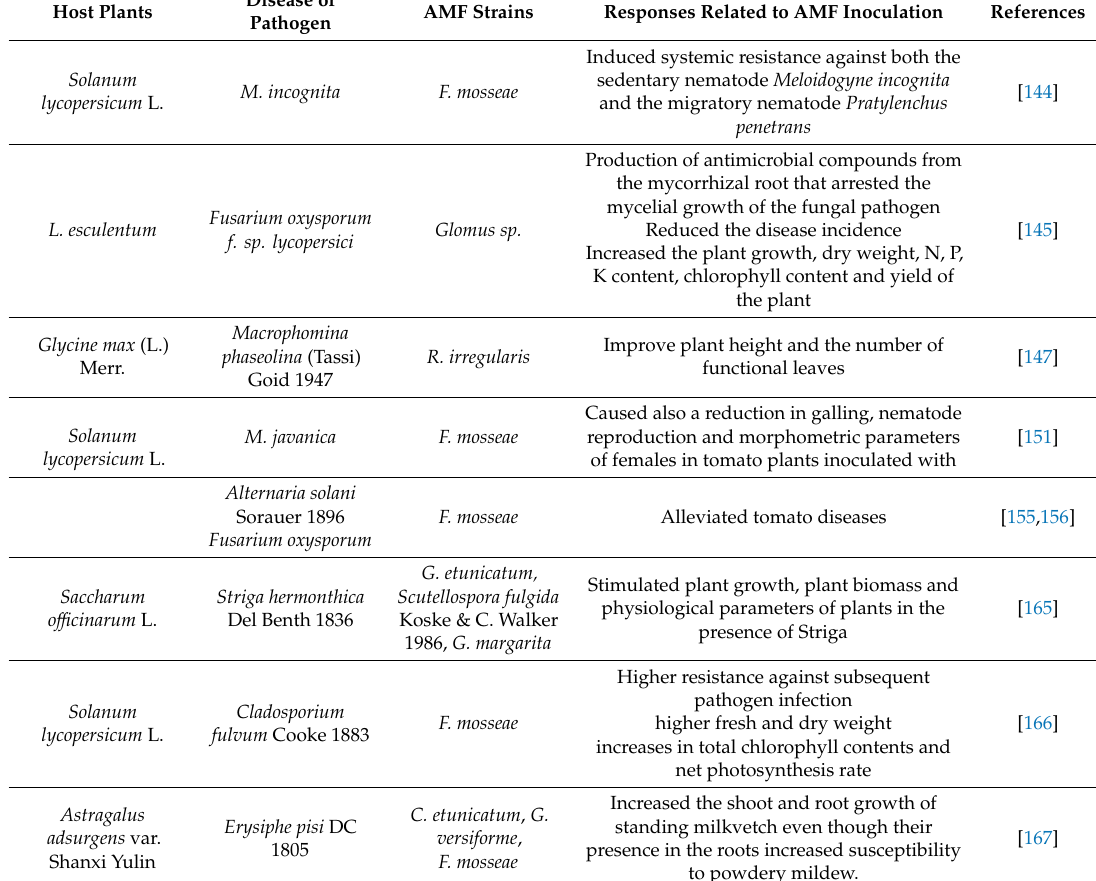
Table 6. Contribution of AMF in helping plants to cope with several biotic